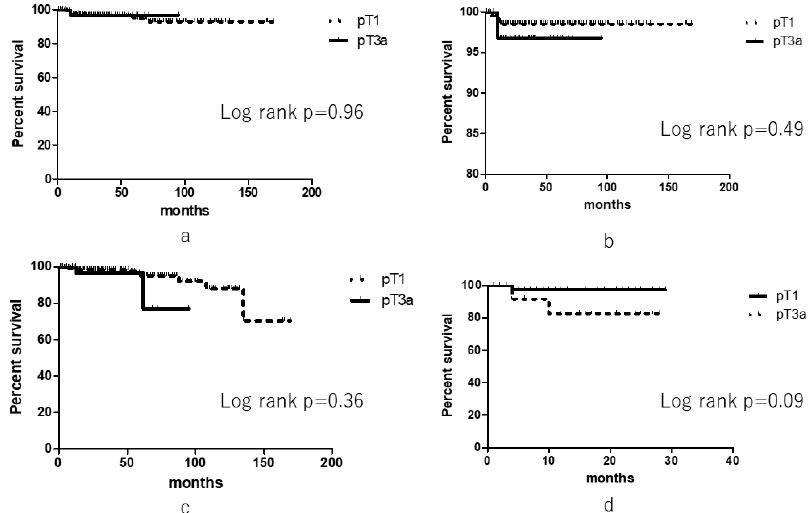
Figure 1. Oncological outcomes of pathological T3 upstaging and pathological T1 patients. ( a ) Overall survival, ( b ) Cancer-specific survival, ( c ) Recurrence-free survival, ( d ) Two-year recurrence-free survival).